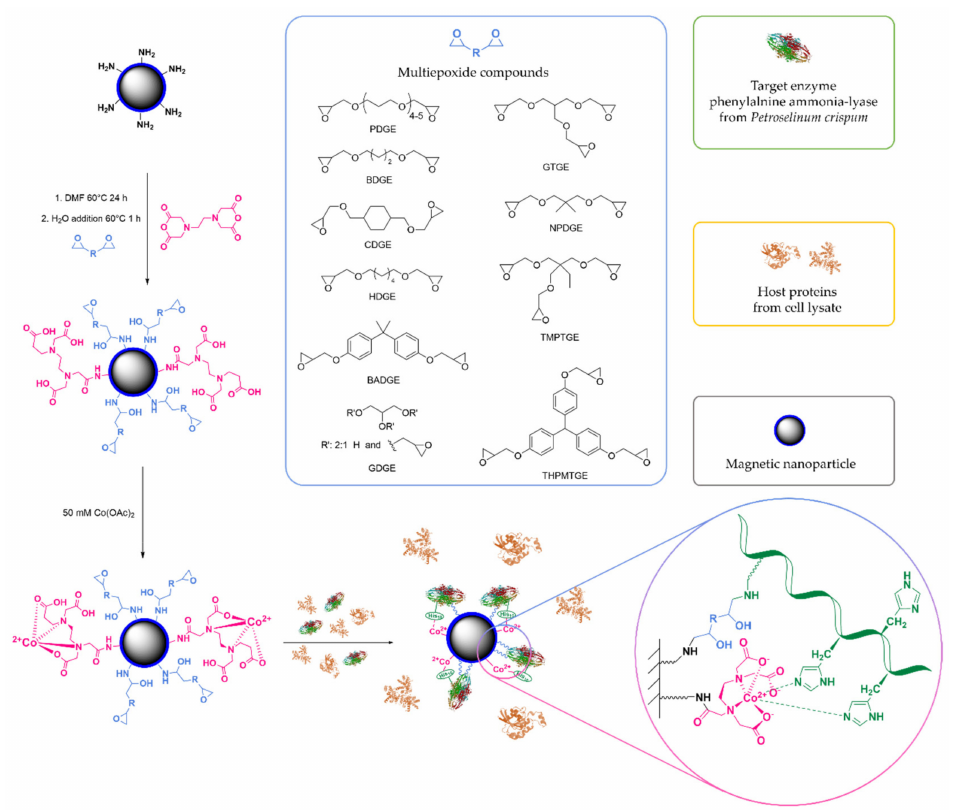
Figure 2. Surface modification of magnetic nanoparticles and immobilization of phenylalanine ammonia-lyase from Petroselinum crispum ( Pc PAL) onto mixed epoxy-chelate magnetic nanoparticles from cell